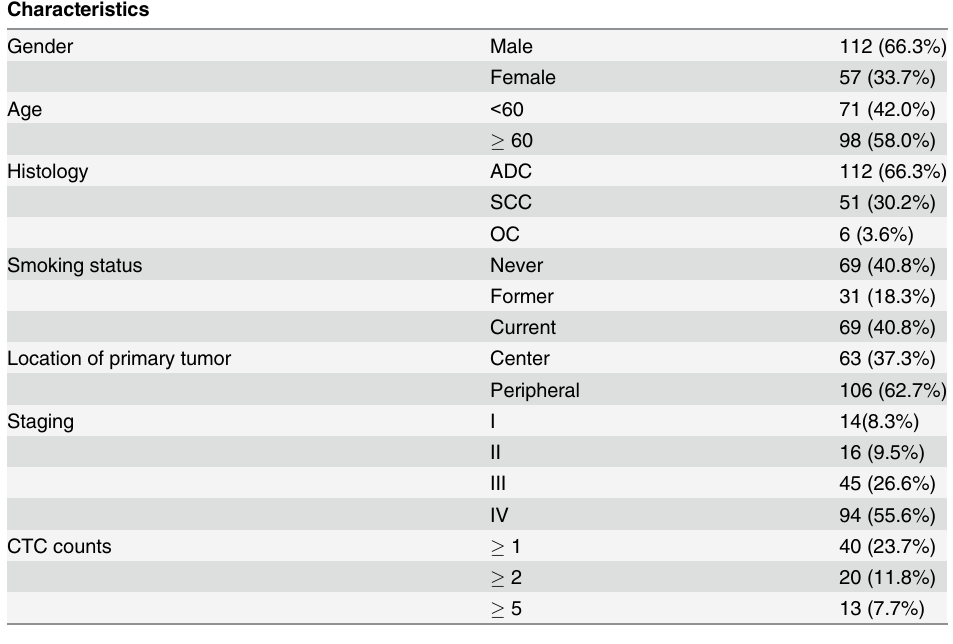
Table 1. Characteristics of NSCLC patients.